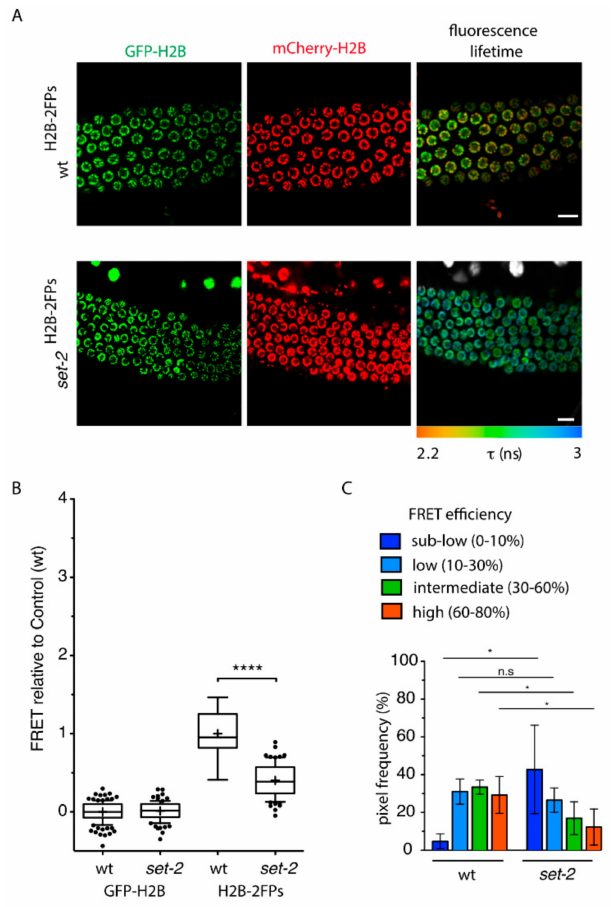
Figure 1. set-2 inactivation influences nanoscale chromatin compaction in the germline. ( A ) Representative confocal images of pachytene-stage germ cells expressing GFP-H2B (green) and mCherry-H2B (red) fluorescent proteins from wildtype (wt H2B − 2FPs ) (top) or set-2(bn129) H2B − 2FPs mutant animals. The corresponding fluorescence lifetime images revealed the spatial distribution of the mean fluorescence lifetime ( τ ) at each pixel of the region of interest. Fluorescence lifetime values are represented using a continuous pseudo-color scale. Scale bars, 10 µ m. ( B ) Graph box-and-whisker plots of the mean FRET e ffi ciency relative to control (wt) showing that set-2 nuclei show reduced chromosome compaction. The mean FRET value is indicated by a cross in each box. **** p < 0.0001 (two-tailed unpaired t test). ( C ) Histogram plots showing the relative fraction of FRET populations (sub-low, low, intermediate, and high) from wt and set-2(bn129) pachytene nuclei. The FRET populations represent the di ff erent levels of compaction as defined previously [31]. * p < 0.05; (two-tailed unpaired t test); n.s, non-significant. n = 5 gonads (approx. 350 nuclei) for wt, n = 6 gonads (approx. 430 nuclei) for